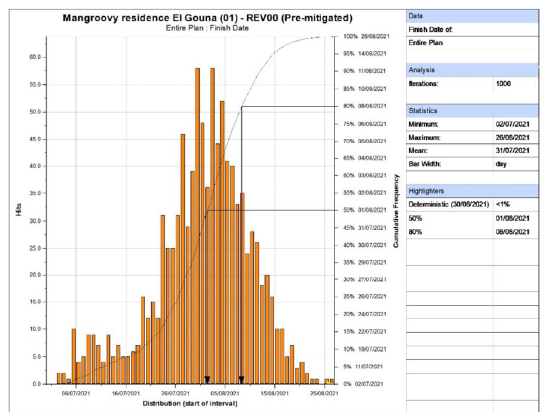
Fig. 9. Schedule check simulation histogram – completion works Fig. 9. Alt Text: Schedule check simulation histogram – completion works: Under the influence of risks with 80% confidence, the project will be completed on